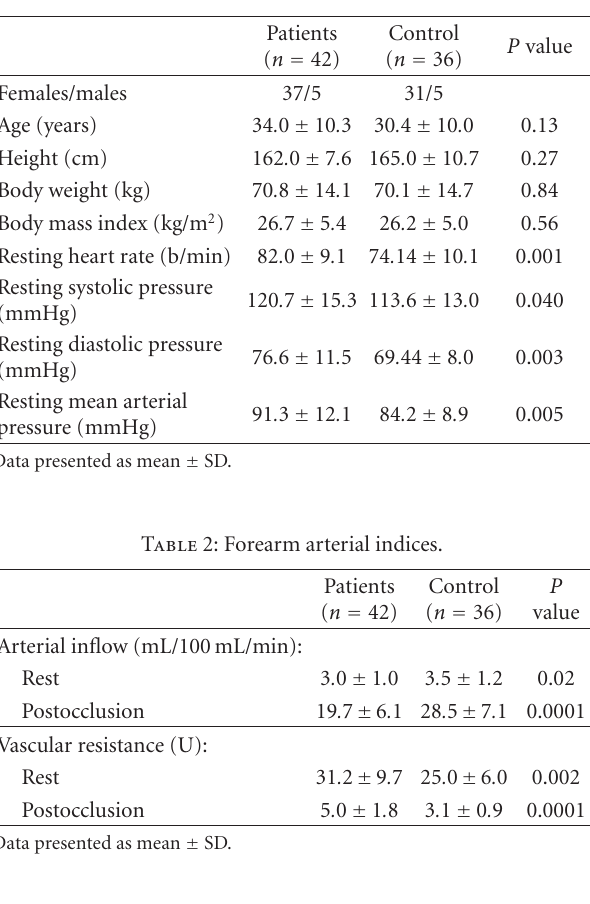
Table 1: Participant characteristics.